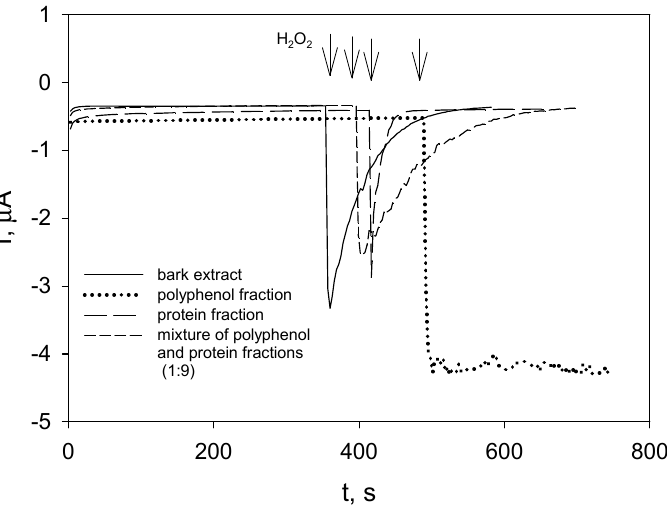
Figure 5. Responses of the GC/PB to the additions of H 2 O 2 to initial R. idaeus bark extract, polyphe- nolic, and enzyme fractions obtained from bark extract and their mixture (as indicated); phosphate buffer pH 6.0; operating potential 0.0 V.